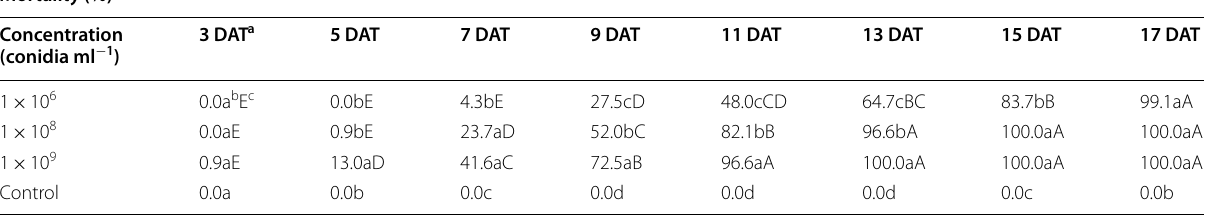
a DAT: Days after treatment b Means in a column followed by the same letter are not statistical significantly different (ANOVA P < 0.05, Tukey’s test) c Means in a line followed by the same capital letter are not statistical significantly different (ANOVA P < 0.05, Tukey’s test) Table 7 Mortality of Tropinota hirta exposed to HP33-1 isolate